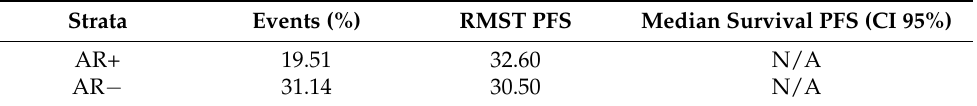
Figure 8. PFS positive/ negative AR. PFS: progression free survival, AR+: androgen receptor positive, AR-: androgen receptor negative Table 4. PFS AR survival data.